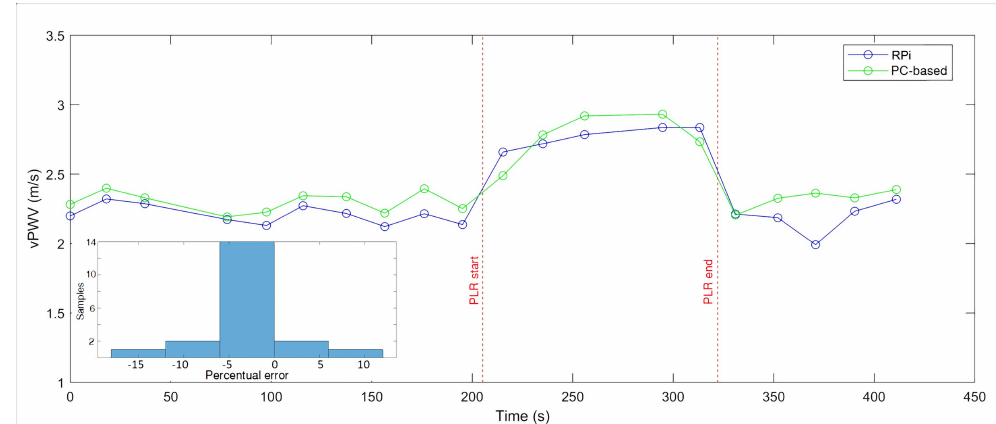
Figure 6. Time course of vPWV during the experimental session in one subject. Values yielded by RPi-based prototype (blue) compared with those returned by original PC-based system